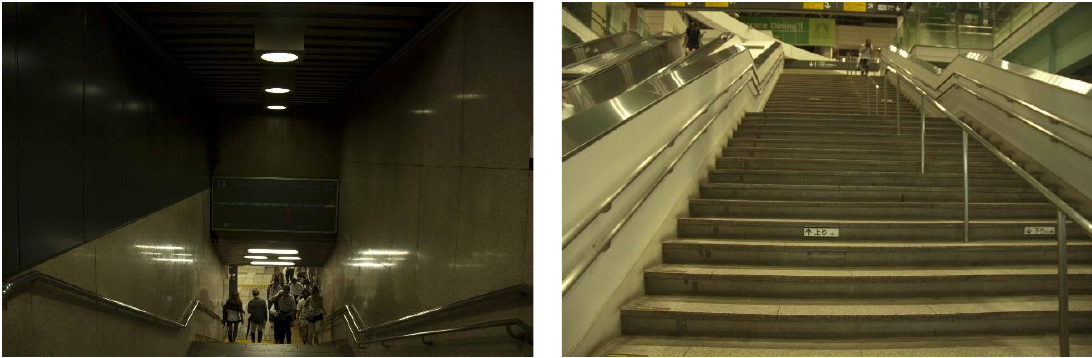
Figure 16. Font views of the No. 10 ( left ) and No. 15 ( right ) platforms.